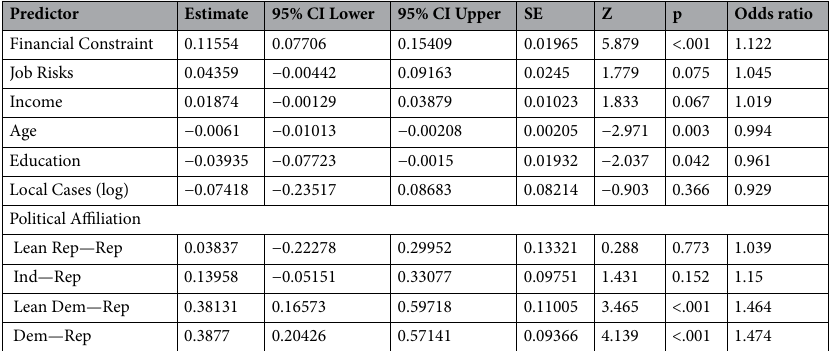
Table 4. Model coefficients for ordinal logistic regression predicting beliefs about national spread.